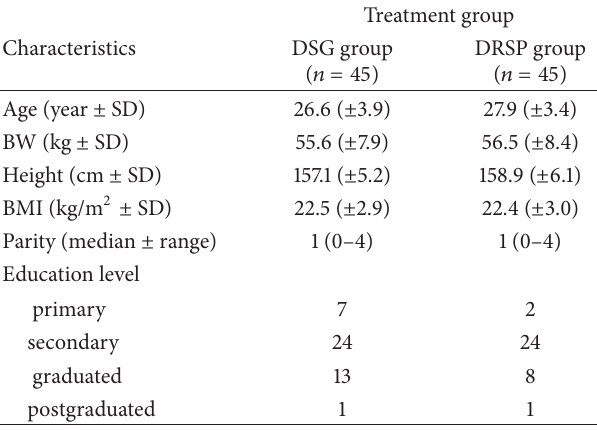
Table 3: Baseline characteristic demographic